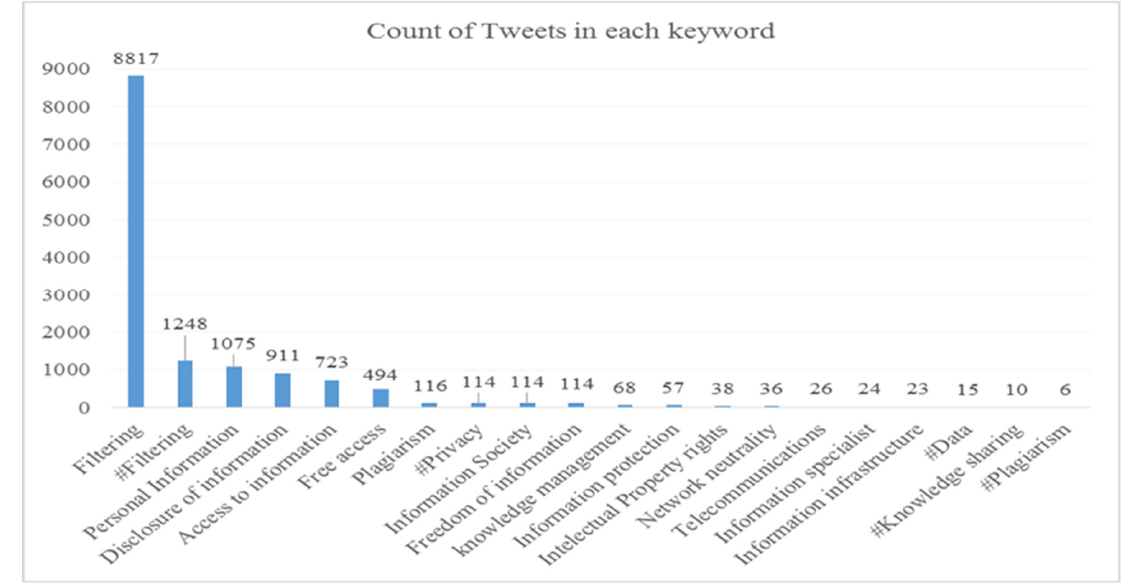
Figure 3. The number of tweets related to each keyword.